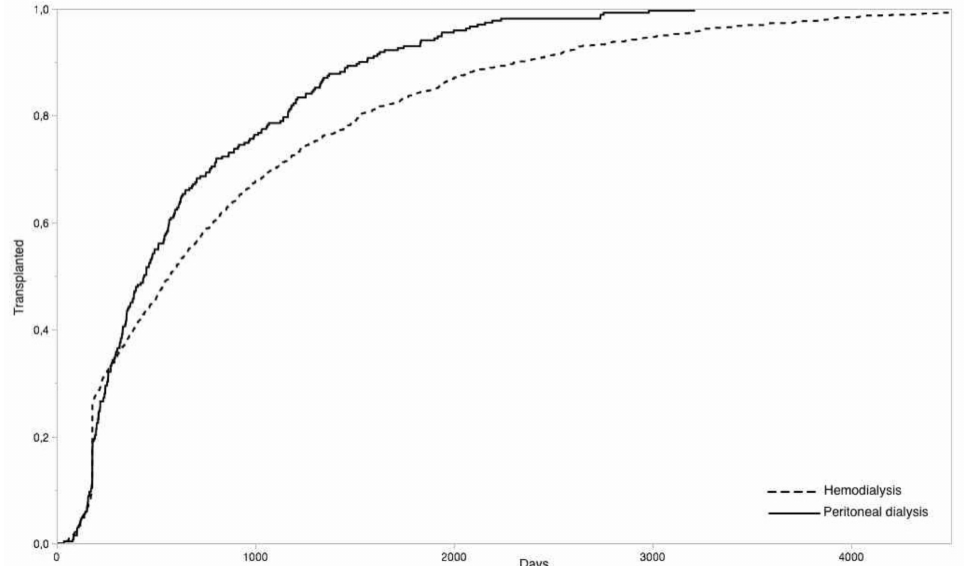
Figure 3. Patients who received kidney transplant divided by type of dialysis. Those who received PD (271 patients) reached the goal (kidney transplant) far earlier than those who received HD (1347 patients) (Log-Rank ChiSquare 21.99, p < 0.0001, Wilcoxon ChiSquare 5.77, p =